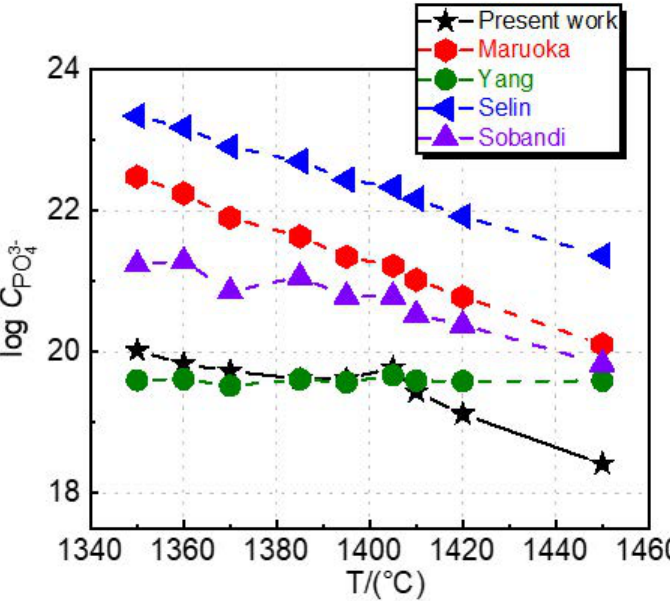
Figure 10. Comparison of log C between the calculated value of the empirical formulas and the PO 3 − 4 calculated value in this paper at different dephosphorization endpoint